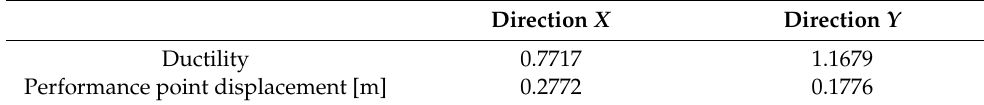
Table 4. Results of the pushover